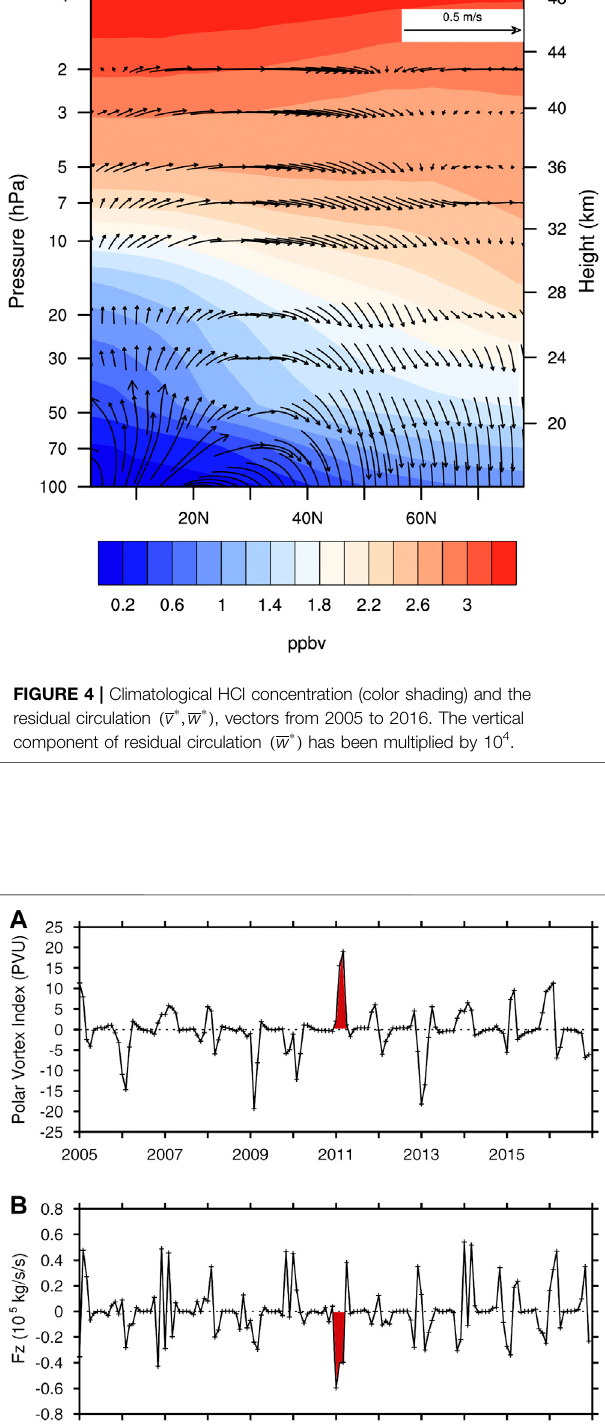
TABLE2| OccurrenceofLaNiñaevents,thewestphaseoftheQBO(WQBO)and positiveSSTanomaliesintheNorthPaci fi c(PNP) inwinterfrom1979to2016.